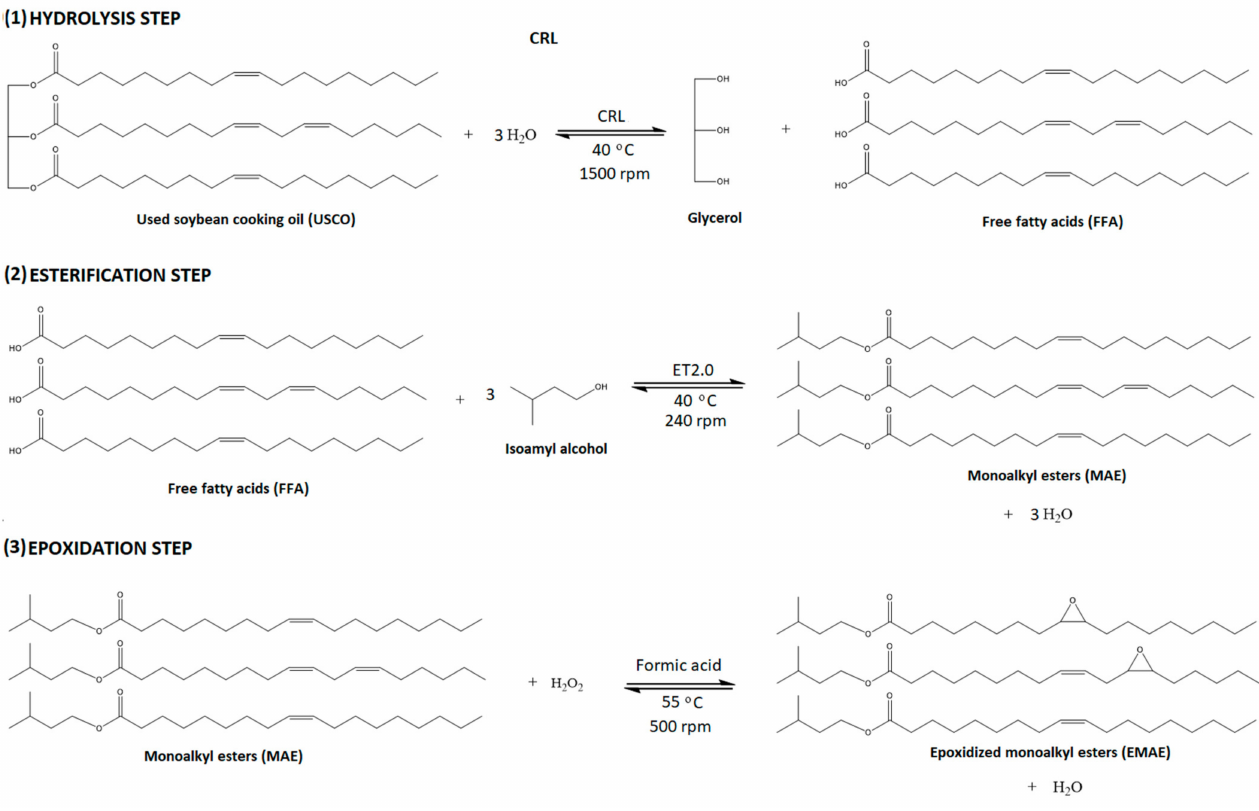
Figure 5. Illustrative scheme of epoxidized monoalkyl esters (EMAE) production from used soybean cooking oil (USCO) and fusel oil via a three-step